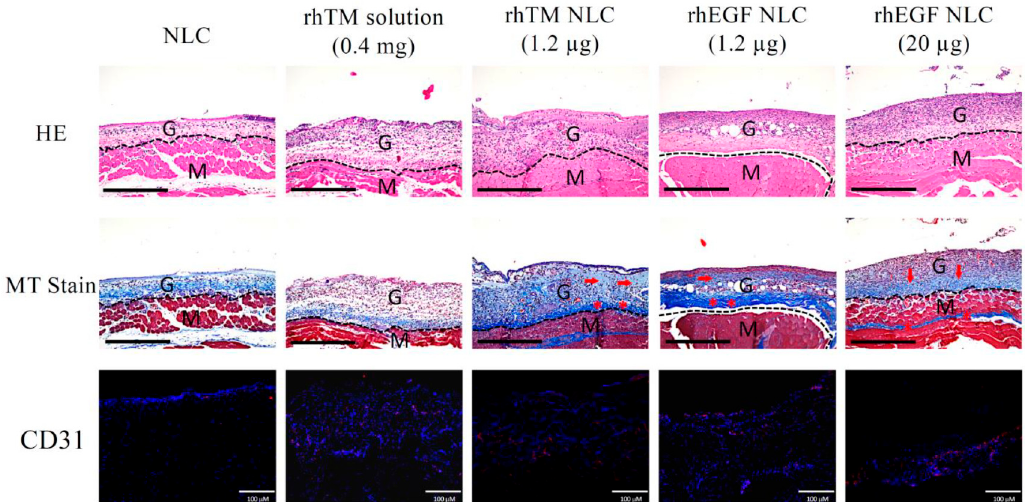
Figure 3. RhTM NLC 1.2 µg increased granulation tissues and enhanced collagen deposition and angiogenesis at the wound site. Wounded skins on Day 10 were collected, fixed, and embedded in paraffin. Samples were stained with hematoxylin and eosin (HE), Masson’s trichrome staining (MT), or CD31, respectively. Representative images of central area of wound were shown. In MT staining, arrows pinpointed newly formed collagen (faint blue) and asterisks denoted deposited collagen (deep blue). Dashed lines denoted boundaries between the granulation tissue and dermis/muscle. G, granulation tissue; M, muscle. In CD31 immunostaining, CD31 and nuclei were visualized as red and blue dots, respectively. Scale bar of HE and MT = 400 µm; scale bar of CD31 = 100 µm.